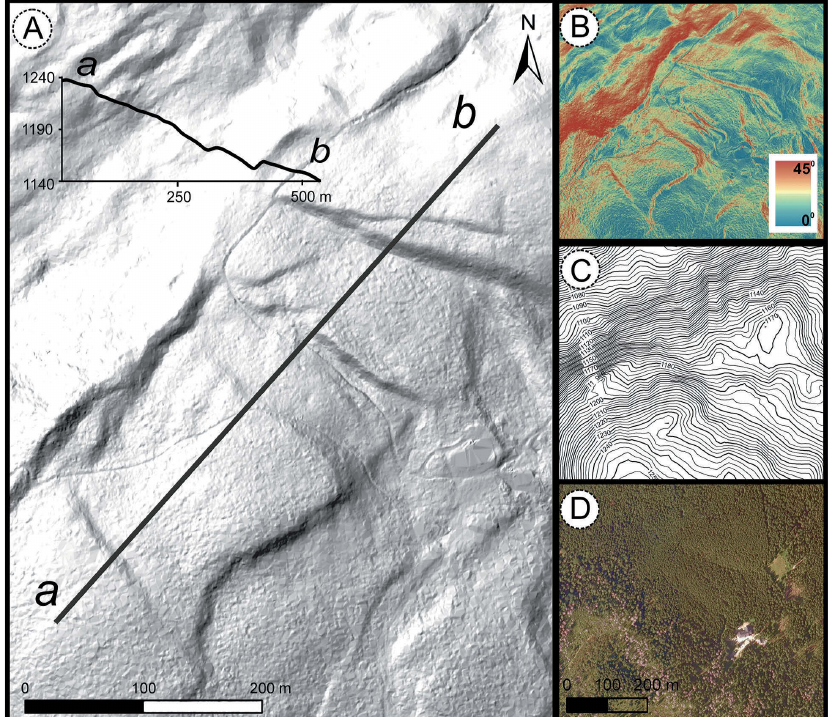
Fig. 7. Test area No 6. A – LiDAR image (a–b – topographic profile and its location), B – the map of slope reductions generat- ed from LiDAR (range of slope reductions is given), C – contour-line map, D – orthophotomap. Maps B–D at the same scale, Map A at larger